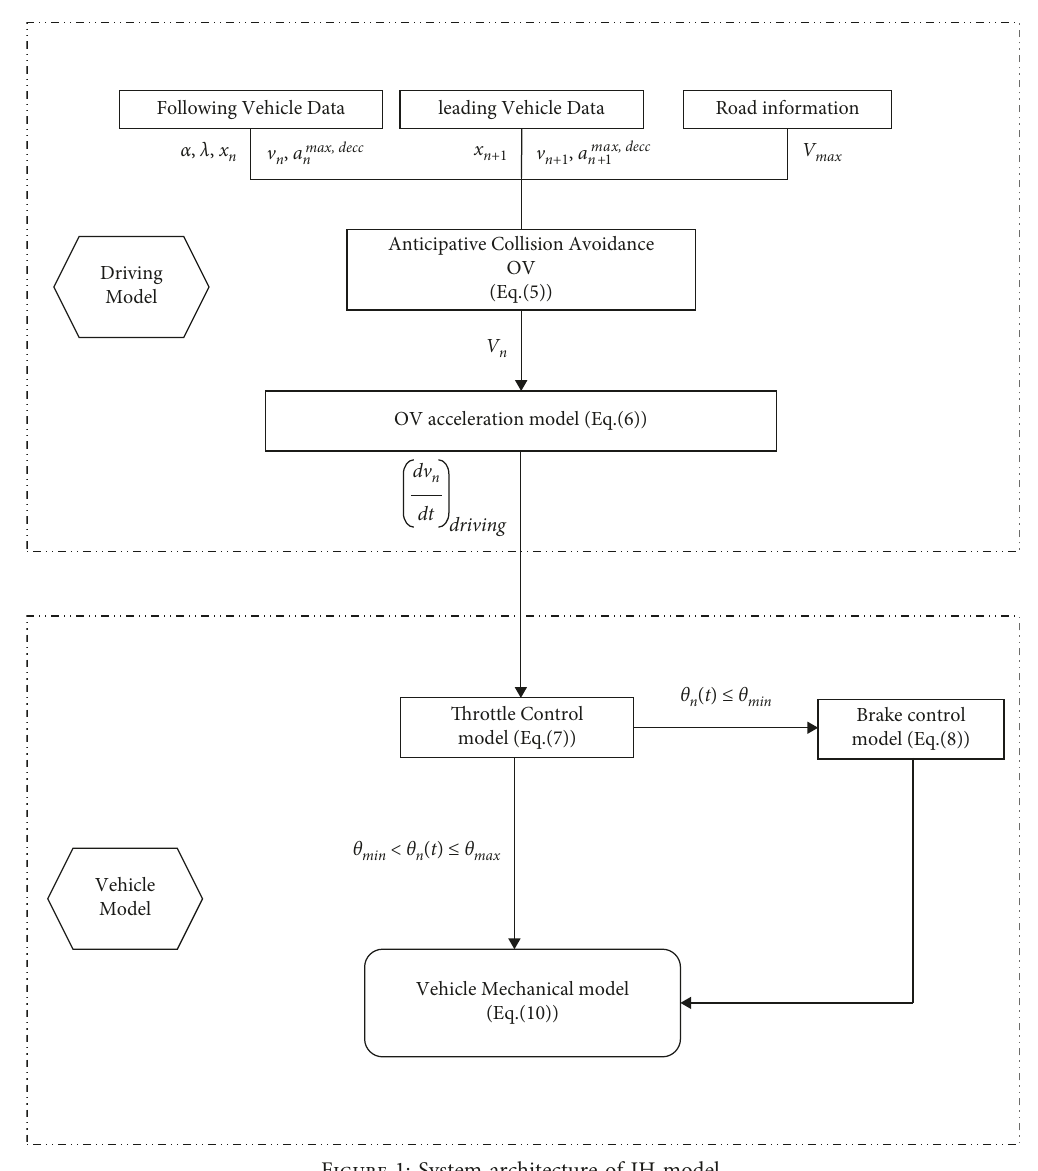
Figure 1: System architecture of IH